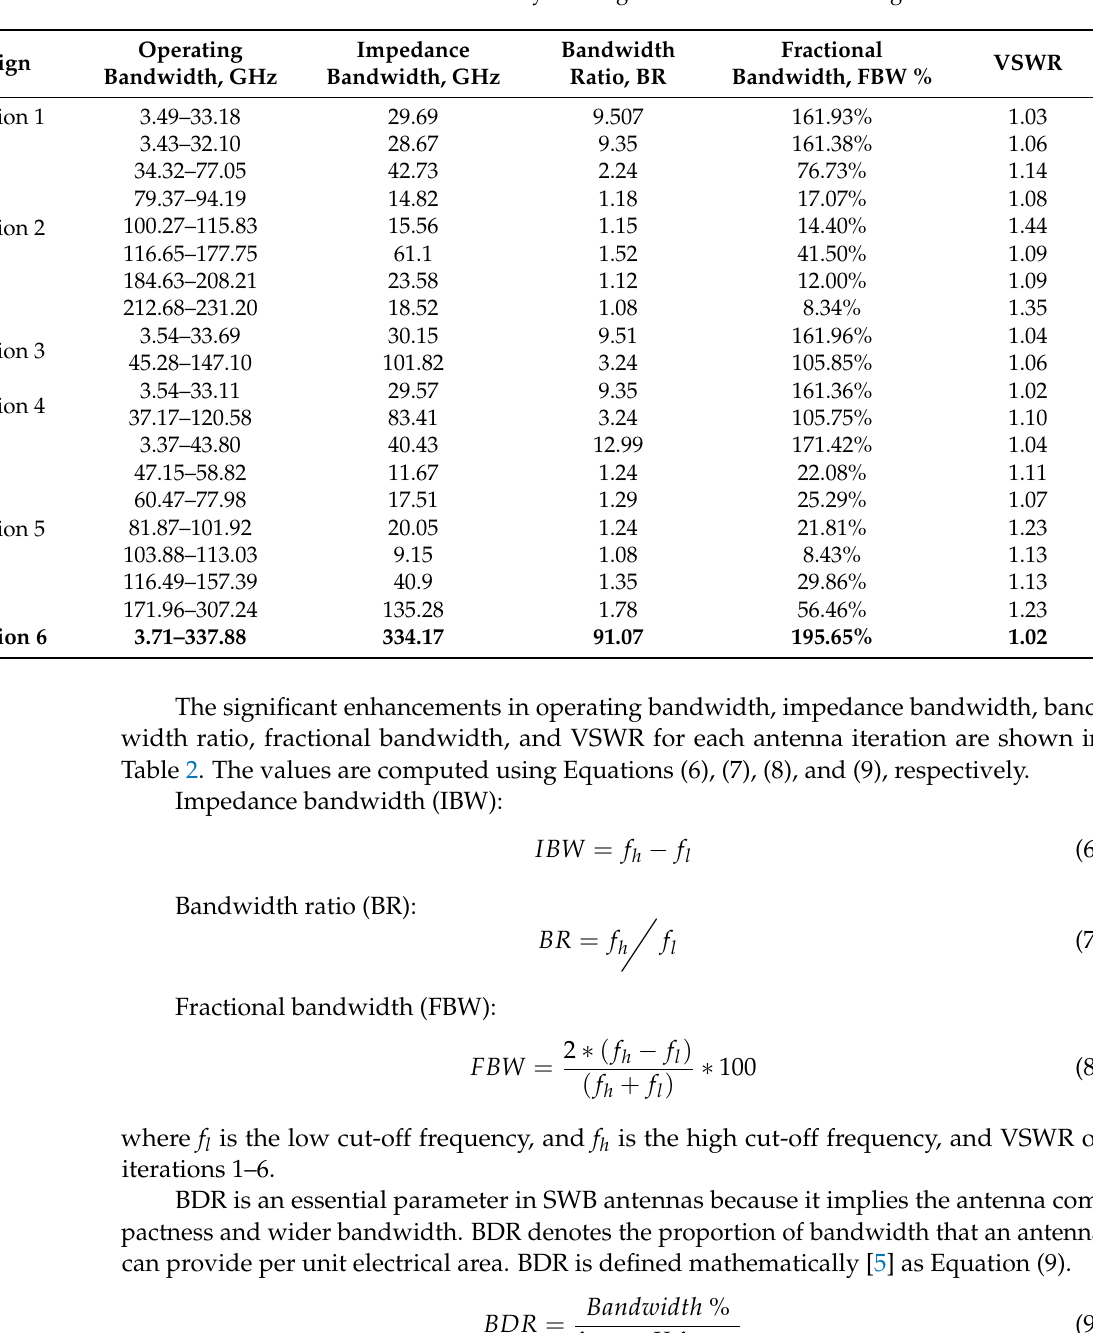
Table 2. Electrical characteristics summary of designed antenna in various